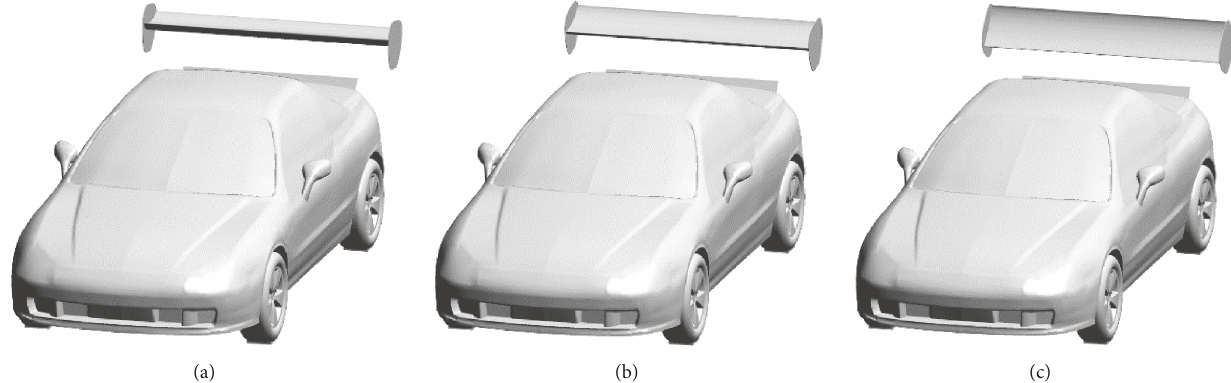
Figure 9: The car body with the rear wing set to the three different angles of attack: (a) 0 ∘ , (b) 20 ∘ , and (c) 50 ∘ .